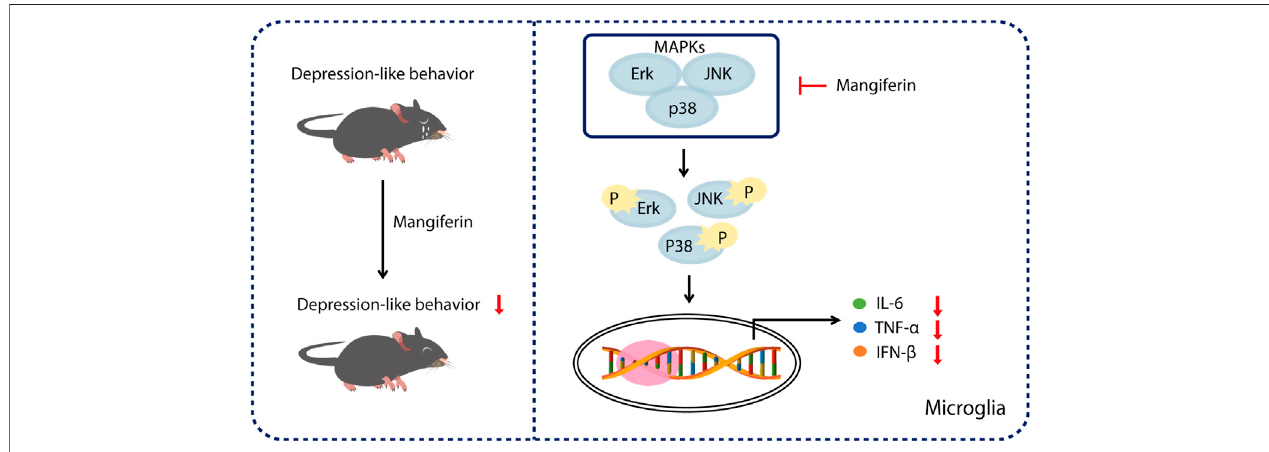
FIGURE6| SchematicrepresentationofthemechanismofMGFintreatmentofPDDinmice.TreatmentofMGFcouldsigni fi cantlyalleviatetheHSP-inducedPPD- like behaviors in mice. Mechanistically, MGF inhibited microglial activation by targeting MAPK signaling in vivo and in vitro